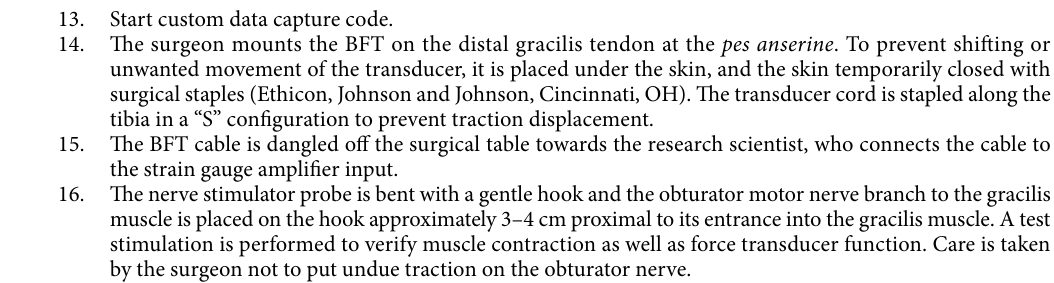
are ligated and the vascular pedicle (artery and two venae commitantes) are dissected to the level of the profunda femoral vessels.